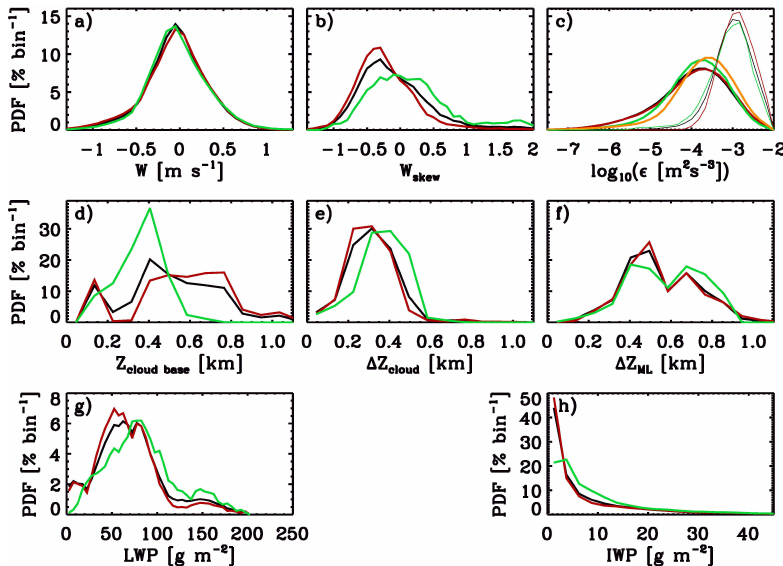
Fig. 13. Probability distribution functions of (a) vertical velocity, (b) vertical velocity skewness, (c) turbulent dissipation rate, (d) cloud base height, (e) cloud thickness, (f) mixed-layer thickness, (g) LWP, and (h) IWP. In all panels, the black curve is representative of all data noted by the thick black bars at the top of Fig. 12, red curves are for predominantly decoupled time periods noted with red cross hatches in Fig. 12, and the green curves are for intermittently coupled time periods noted with green cross hatches in Fig. 12. Additionally, (c) includes the PDF of ε for predominantly decoupled time periods but only within the mixed layer (orange), and the thin curves represent the PDFs of layer-maximum ε